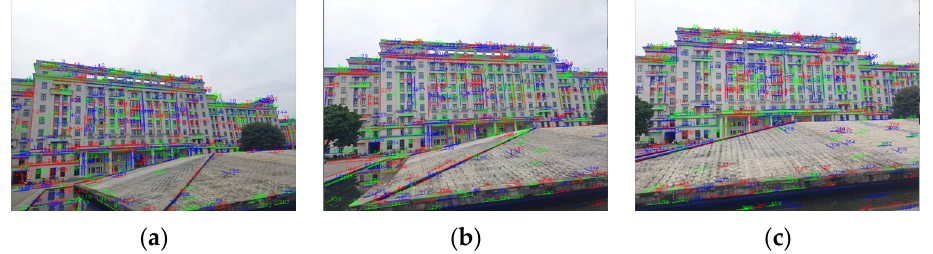
Figure 7. The extracted line features from the multi-angle images of the first scene: ( a ) the 0° image; ( b ) the 15° image; ( c ) the 35° image. After rough matching, 137 matched line pairs are obtained from the 0° image and 15° image, as shown in Figure 8. Then, the 15° image in Figure 6 is transformed by a corresponding affine model. On this basis, fine matching is carried out and the results are shown in Figure 9.